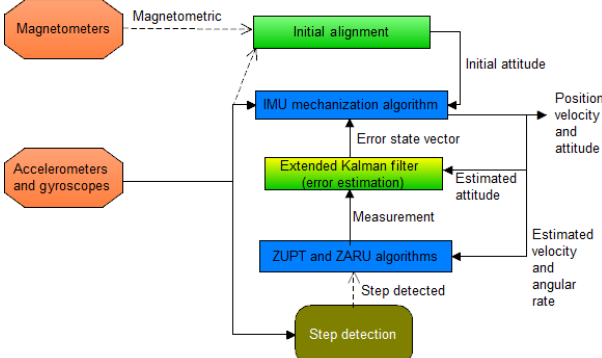
Figure 1. The framework of pedestrian dead reckoning indoor po-